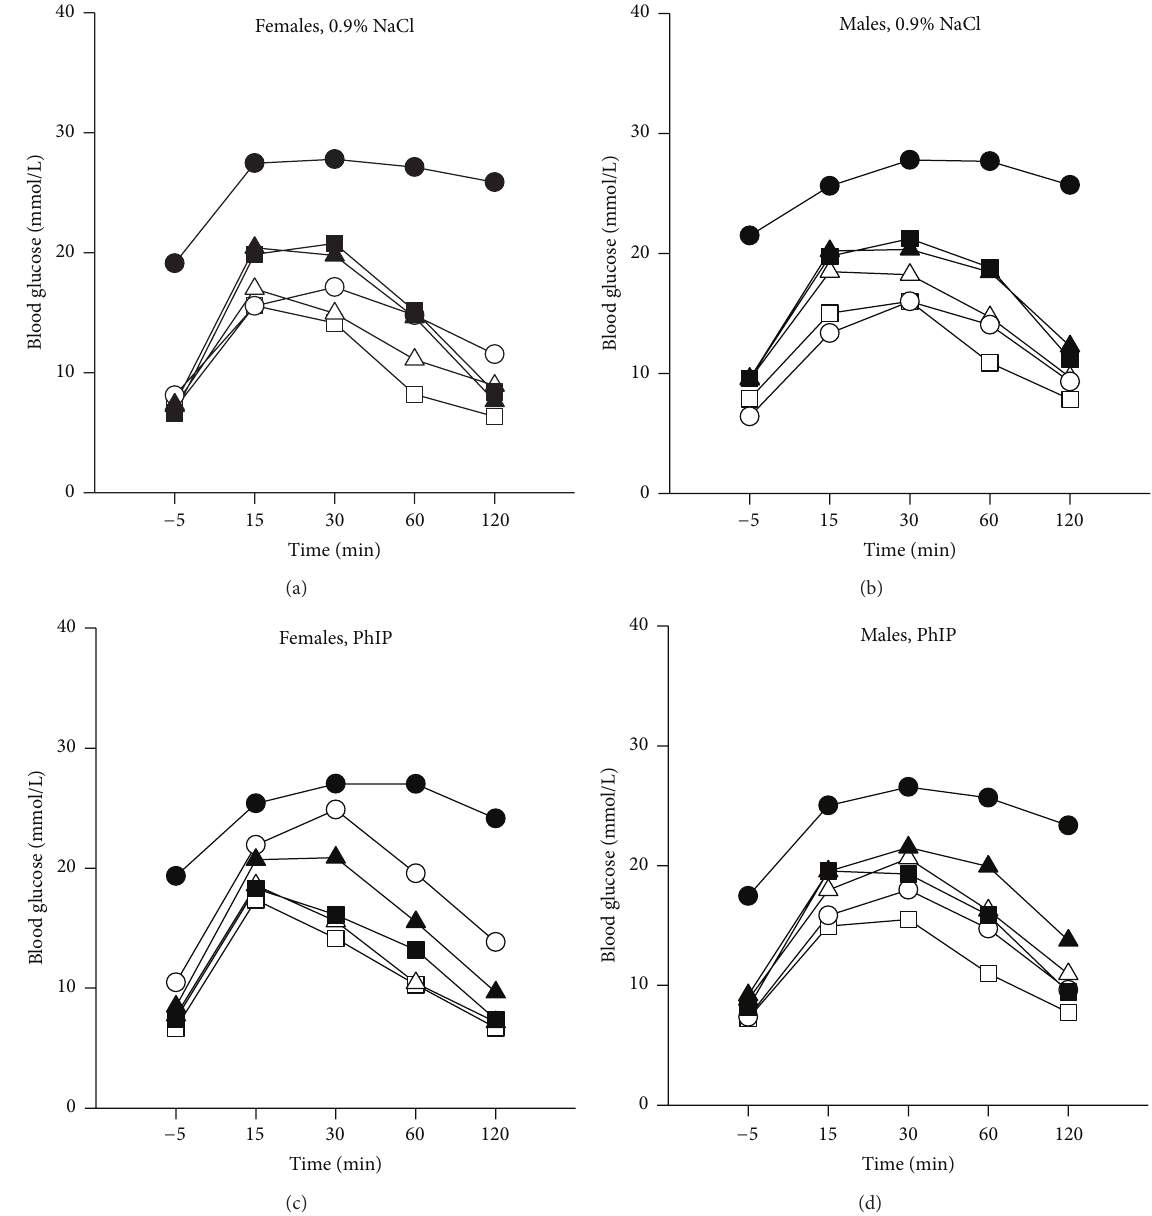
Figure 5: Blood glucose levels as area under the curve (AUC) from a glucose tolerance test (GTT). The GTT was performed on mice fasted for 6 h at 6 weeks of age. Blood glucose was measured 5min before and 15, 30, 60 and 120min after an i.p. injection of 2 g/kg bw glucose. The data were pooled for Apc Min/+ and Apc +/+ mice. The mice were treated with either 0.9% NaCl, (a) females and (b) males, or with PhIP, (c) females and (d) males. The mice had ob genotype ob/ob ( I ), ob/wt ( 󳵻 ) or wt/wt ( ◻ ) and were given a 10% fat diet (open symbols) or a 45% fat diet (filled symbols). 𝑛 = 4 –9